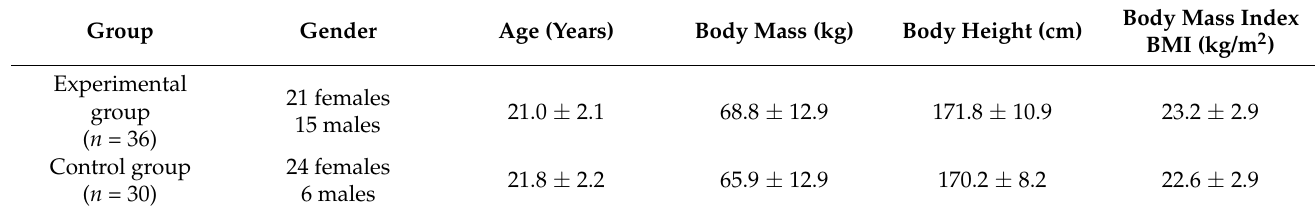
Table 1. Characteristics of the participants (mean ±